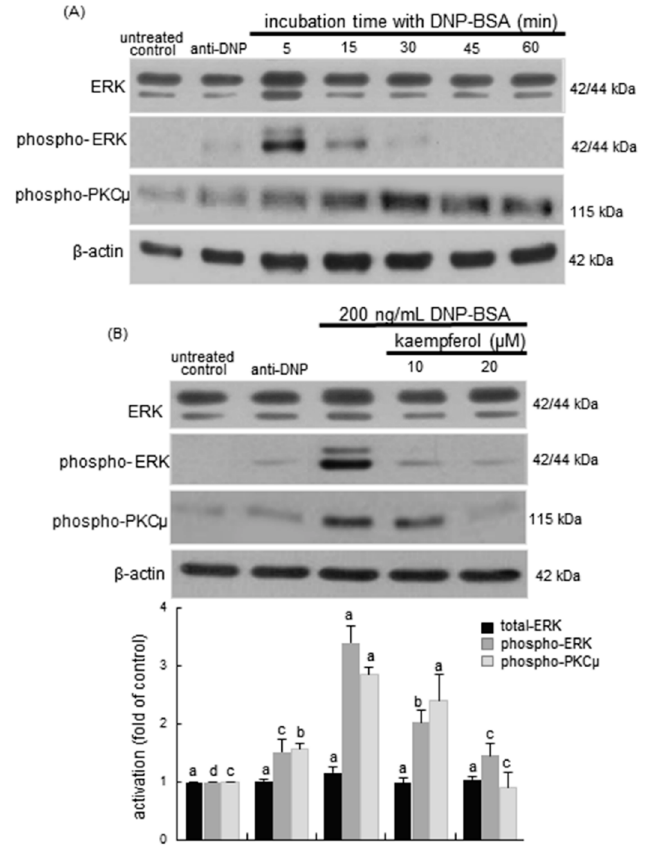
Figure 8. Time course responses of the activation of protein kinase C μ (PKC μ ) and extracellular signal-regulated kinase (ERK) ( A ); and inhibitory effects of kaempferol on cellular levels of total ERK, phospho-ERK and phospho-PKC μ ( B ) in sensitized RBL-2H3 cells. Rat basophilic leukemia RBL-2H3 cells were sensitized by addition of 0.5 μ g/mL anti-2,4-dinitrophenol (anti-DNP) and stimulated for 5–60 min with 200 ng/mL of DNP-bovine serum albumin (BSA) in the absence and presence of 10–20 μ M kaempferol. Equal amounts of cell lysate proteins were subject to 8% SDS-PAGE and Western blot analysis with a primary antibody against total ERK, phospho-ERK, and phospho-PKC μ . β -Actin protein was used as an internal control for total ERK, phospho-ERK, and phospho-PKC μ . The bar graphs (mean ± SEM, n = 3) in the bottom panel represent quantitative results obtained from a densitometer. Values not sharing a common letter refer to significantly different at p < 0.05.